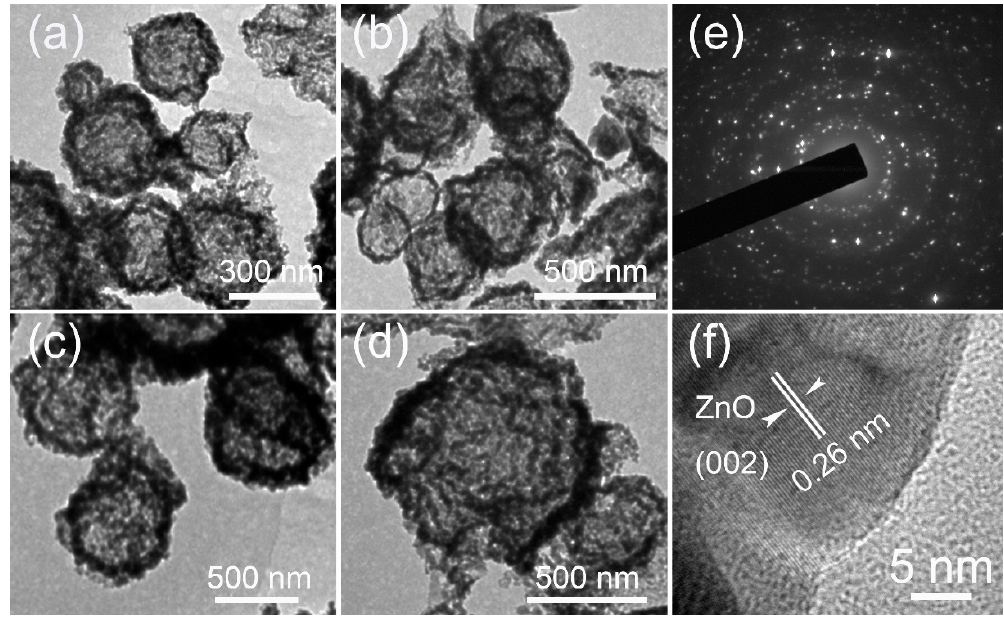
Figure 3. ( a – d ) TEM images of ZnO HS with a size of ~300, ~400, ~500 nm, and ~800 nm, respectively; ( e ) SAED pattern of ZnO HS; ( f ) the HRTEM of ZnO HS.